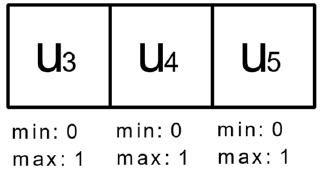
Figure 6. Chromosome structure in Strategy #1.